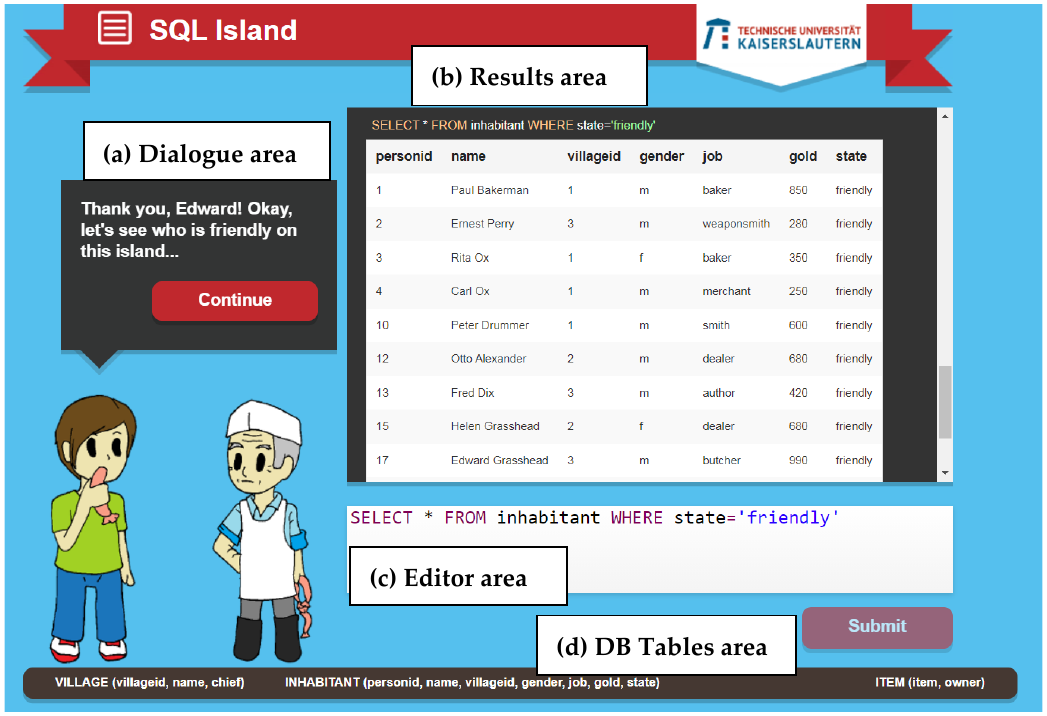
Figure 1. The GUI of SQL Island.